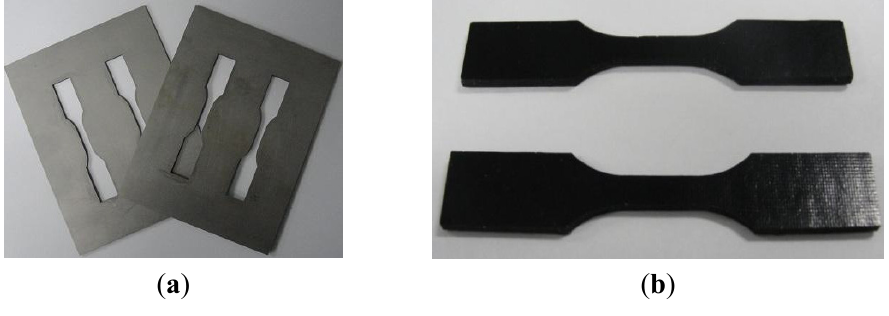
Figure 3. ( a ) Aluminum mold; ( b ) nanocomposite specimens.